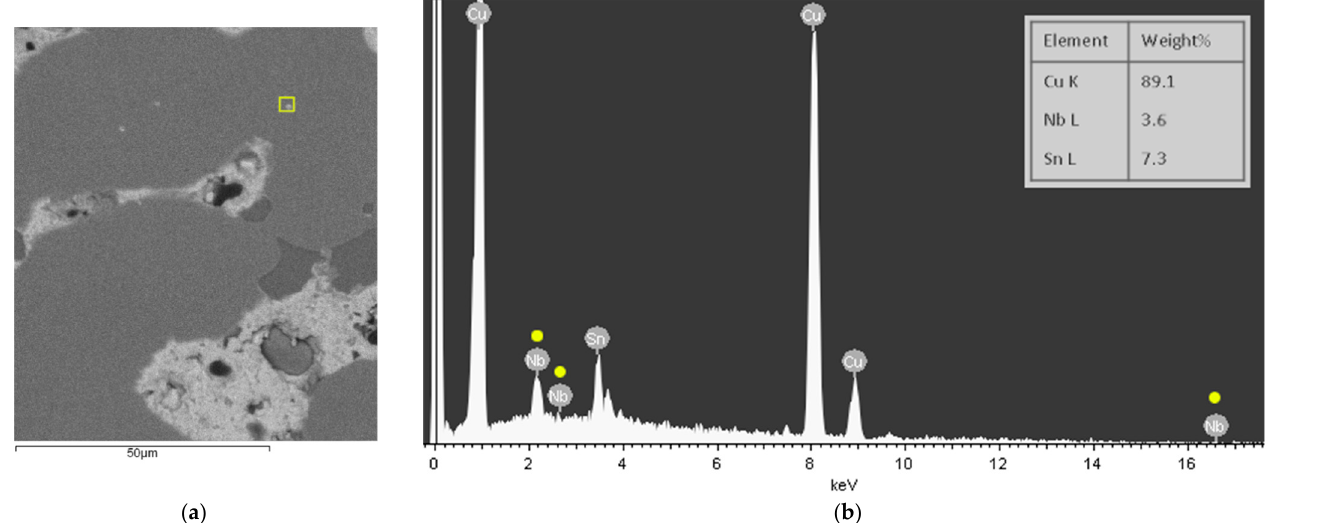
Figure 8. SEM-EDS analysis of the CE 3.319 (F) metallurgical debris (metallic nodule): ( a ) BSE image area with alpha-phase (Cu-Sn) (gray matrix), large lead-phase (white) and a highlighted small inclusion rich in Nb; ( b ) EDS spectra of analysis performed on the selected highlighted area in ( a ), where Nb is clearly visible among the Cu and Sn elements in the alpha phase.